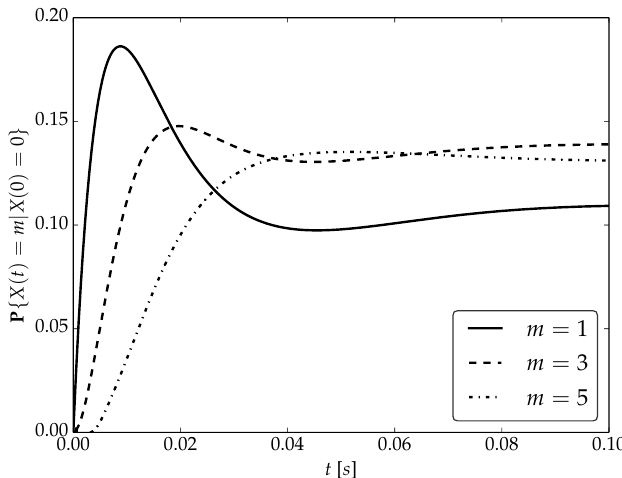
for P 2 , ρ = 0.75 and mean setup time equal X ( t ) = m X ( 0 ) = 0 { | }